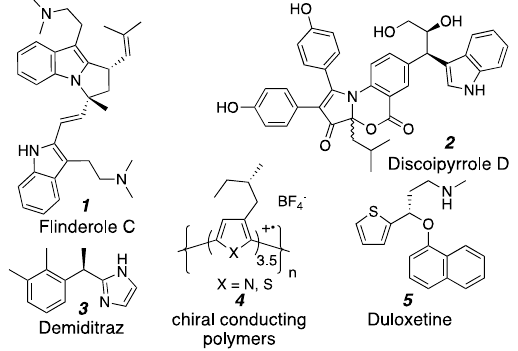
Figure 1. Examples of chiral heteroaromatic compounds.